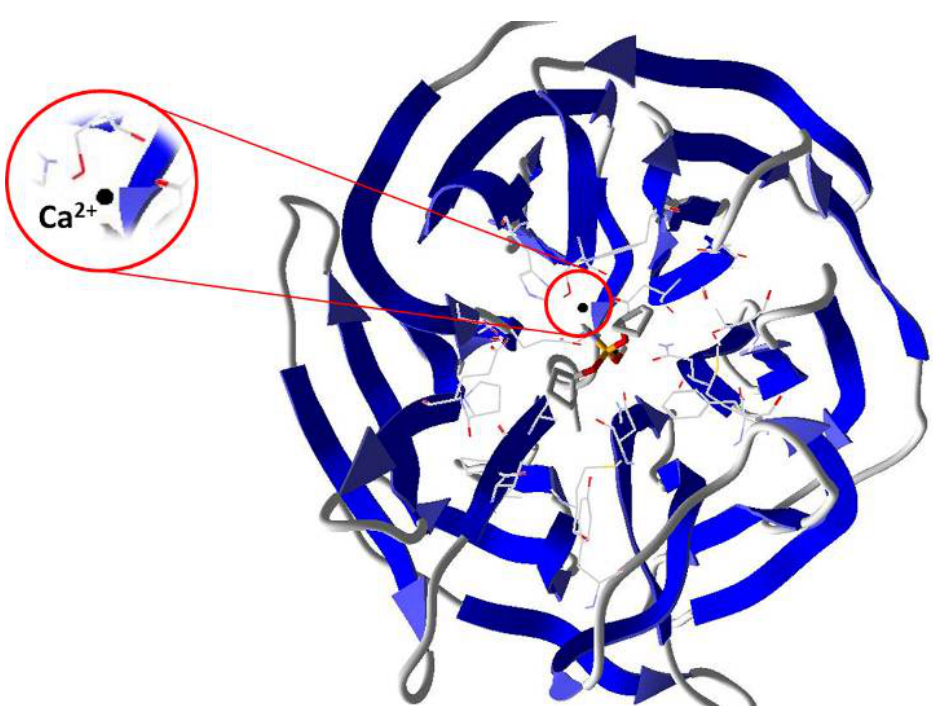
Figure 2. Representation of DFPase crystallographic structure (PDB code 2GVV) [13]. The DFPase structure is shown as solid ribbons. The original ligand (DcPPA) is shown as tubular bonds.